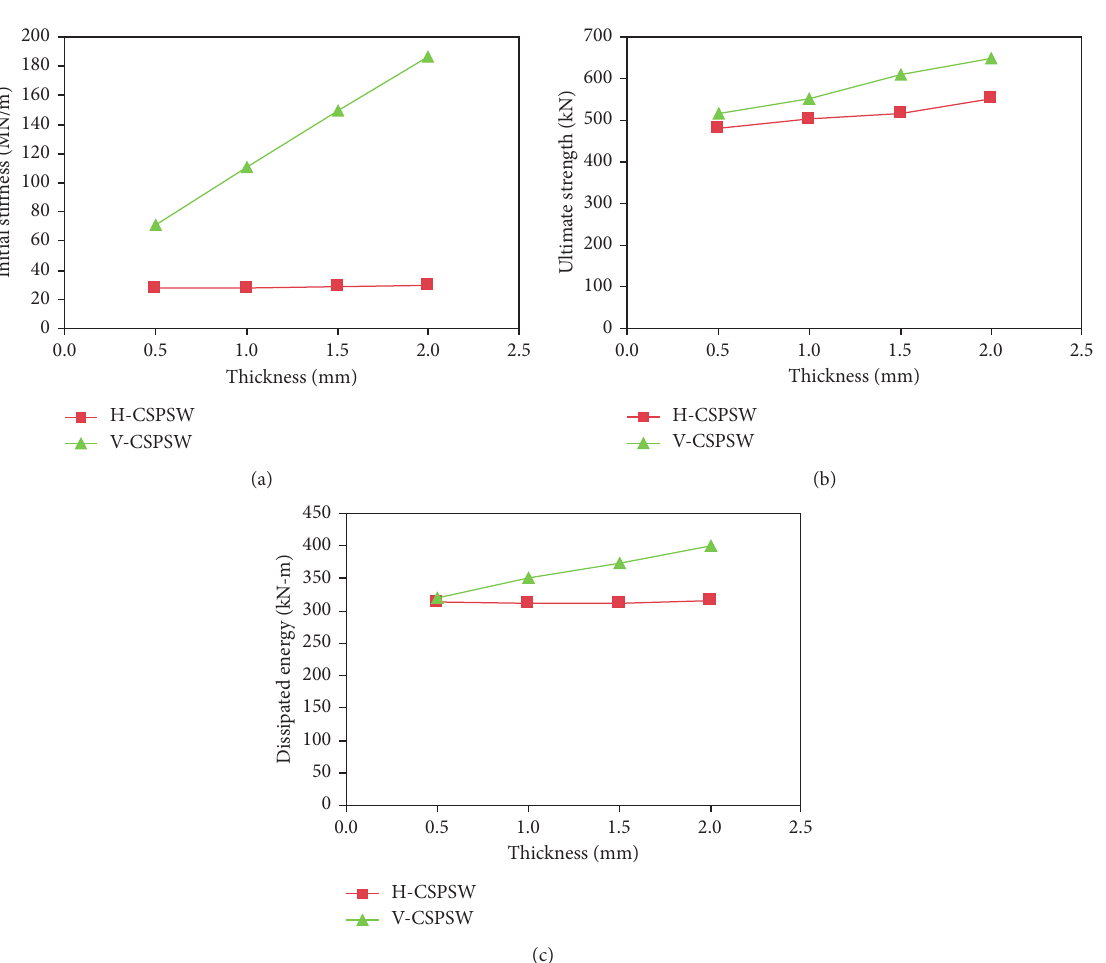
Figure 15: The responses of H-CSPSWs and V-CSPSWs as functions of infill plate thickness. (a) Initial stiffness. (b) Ultimate strength. (c) Dissipated